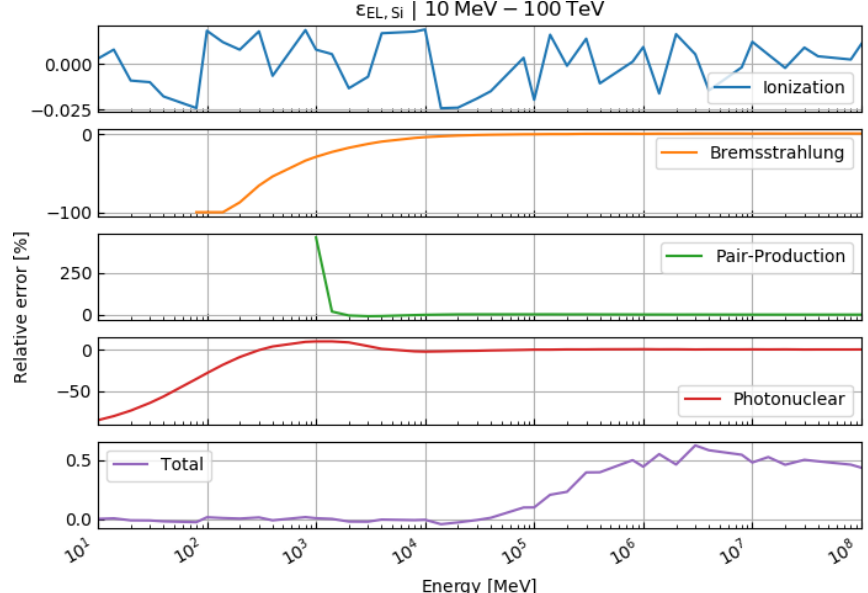
Figure E2. Relative error of our energy loss calculations compared to the tabulated values from Groom et al. (2001) for silicon. Ionisation losses agree very well with the literature values (within 0.025%). At low energies, the relative errors of the radiative processes are large and converge to a value close to 0 towards higher energies, resulting in a relative error on the total energy loss of around 0.5% compared to the literature.